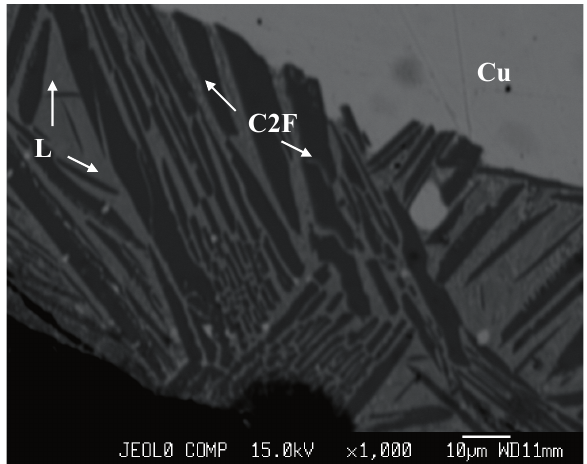
Figure 7. Microstructure of quenched slags in Ca-Cu-Fe-O system equilibrated with metallic copper. Legend: Cu- metallic copper, L-former liquid phase, C2F-dicalcium